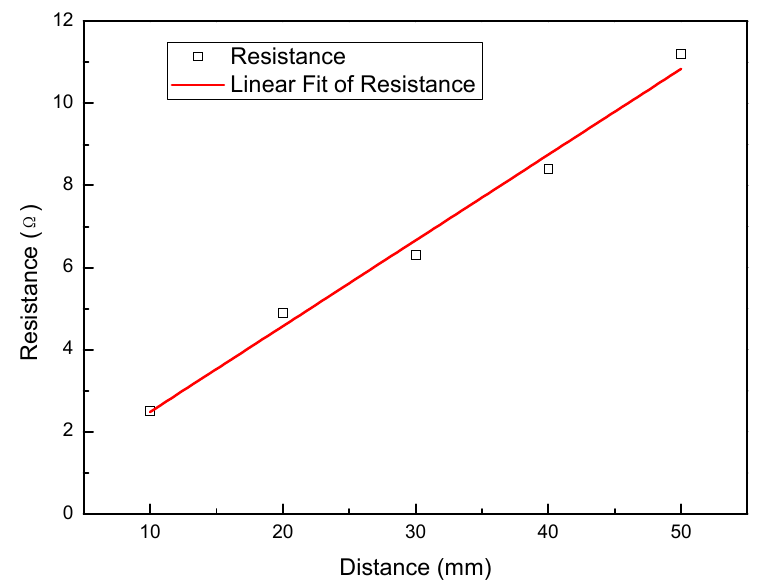
Figure 5. Surface resistances of the IPMC (L4).